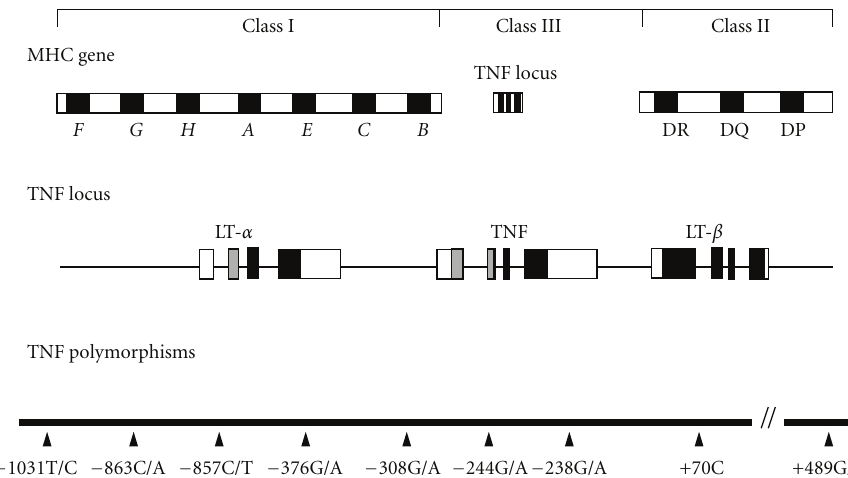
Figure 1: Schematic representation of the location of the TNF gene within the major histocompatibility complex. The position of the most important SNPs in the TNF gene is indicated (adapted from